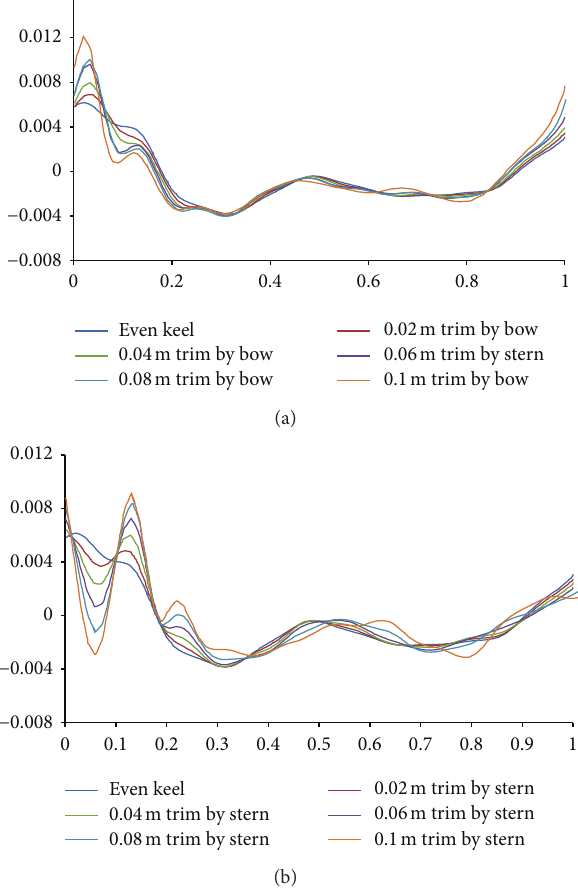
Figure 12: Predicted wave profile at Fn = 0.2274 in different trim